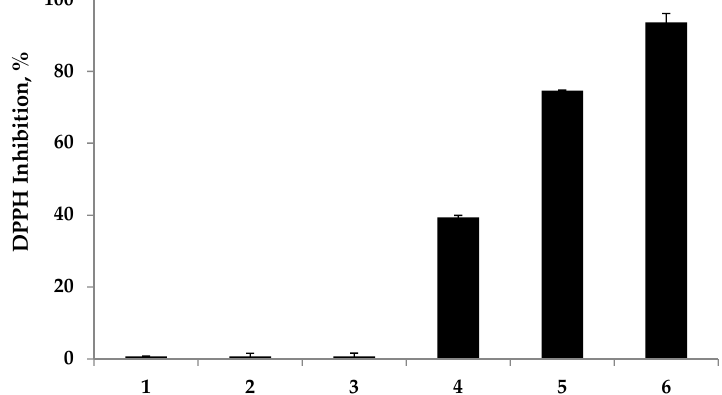
Figure 5. Radical scavenging capacity of the prepared antioxidant hydrogels against 2,2-diphenyl-1- picrylhydrazyl (DPPH) free radicals. The amount of ascorbic acid was 0.85 μ mol. Legend: 1 = poly(2- hydroxyethyl methacrylate) (p(HEMA)); 2 = low-methacrylamide chitosan hydrogel (MC-H); 3 = high-MC-H; 4 = low-MC-gallic acid (GA); 5 = high-MC-GA; 6 = ascorbic acid.